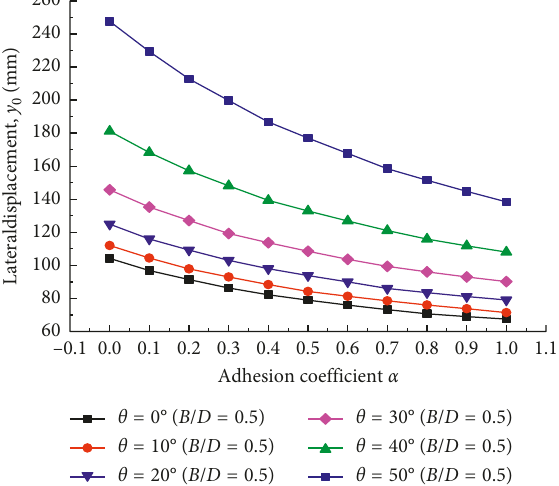
Figure 21: Pile head deflection ( y efficient ( α ) for different slope